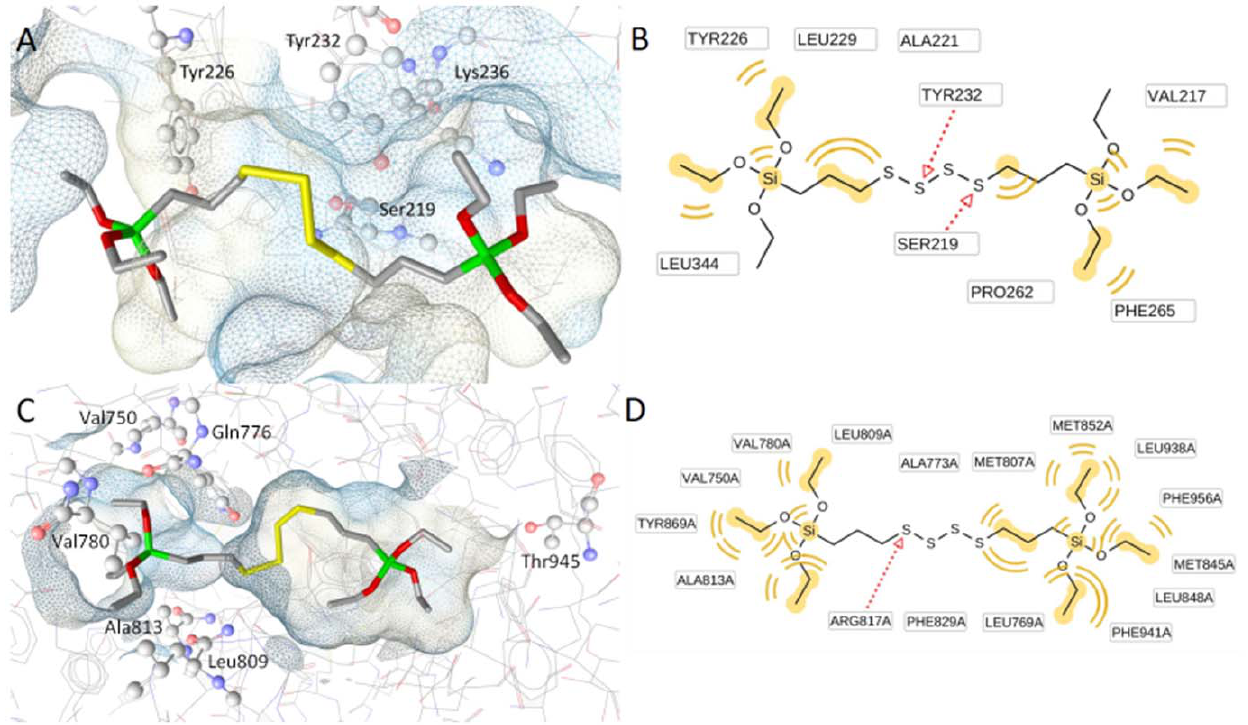
Figure 8. AB110873 binds to both 11 b -HSD2 and MR. Proposed binding modes of AB110873 in 11 b -HSD2 ( A,B ) and in the MR ( C,D ). In the 3D- figures, selected amino acid residues are highlighted with ball and stick, and the receptor binding pockets are colored by aggregated lipophilicity (grey)/hydrophilicity (blue). The 2D figures represent the binding interactions, color-coded as following: red arrow – hydrogen bond acceptor, yellow – hydrophobic interaction.